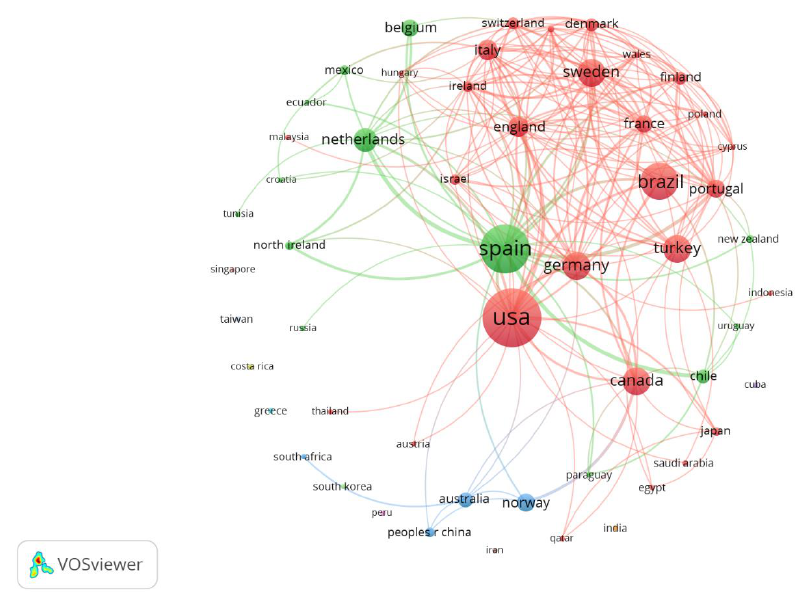
Figure 5. Clusters formed by